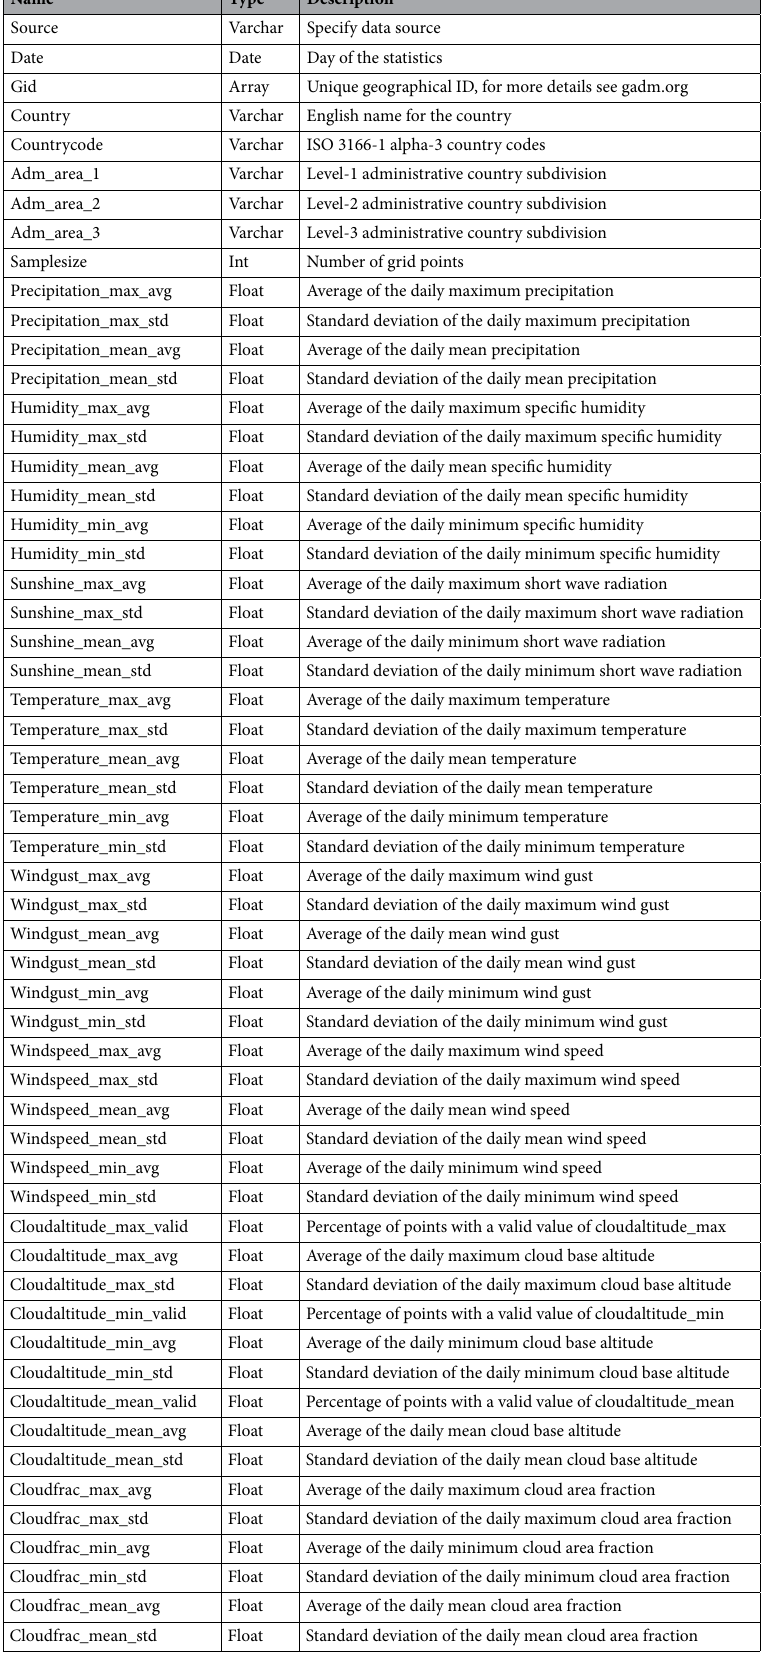
Table 5. Schema for WEATHER